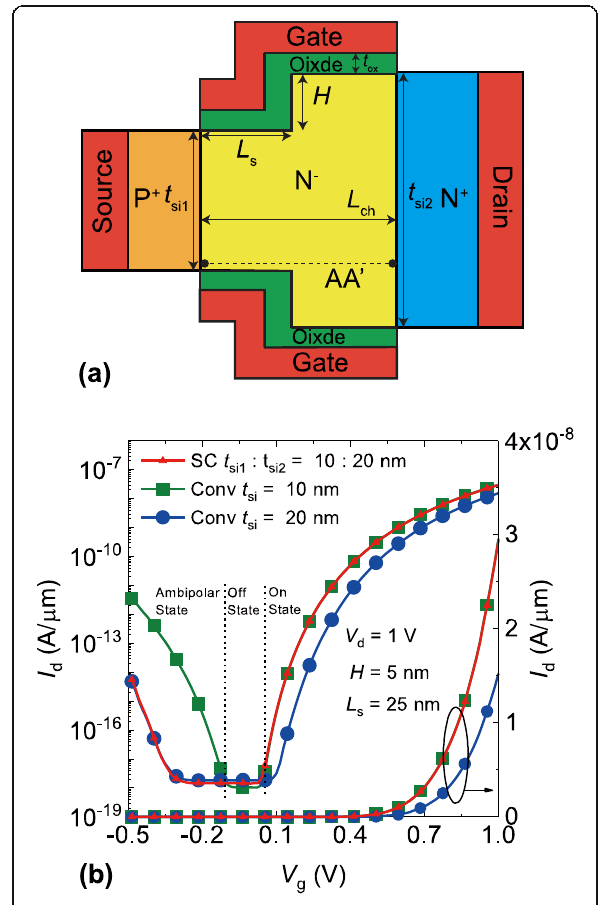
Fig. 1 a 2D schematic diagram of the SC TFET, t si1, and t si2 are the channel thickness near the source region and the drain region, the asymmetry between the source and drain is obviously introduced. Cutline AA ’ is the cutline along the horizontal direction. The vertical distance between the cutline and the surface of source region is 0.5 nm. b Transfer curves of the SC TFET and the conventional DG TFETs in log and linear